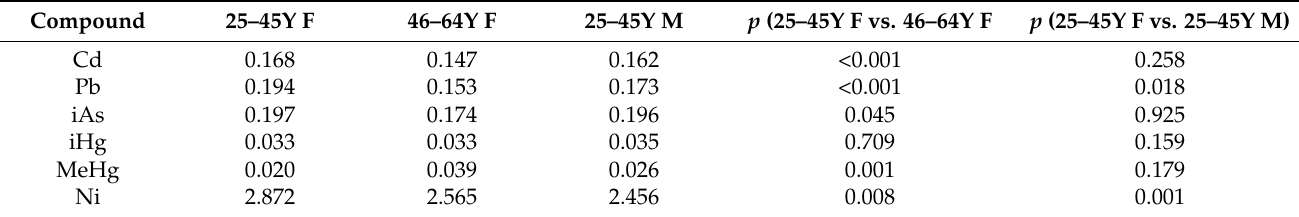
Table 5. Statistical comparison of mean exposure (in µ g/kg bw/d) in three population groups: women (F) and men (M) of 25 to 45 years, and women of 46 to 64 years. The mean exposure was assessed with FinDiet 2012 consumption data. An independent samples t -test was used, and equal variances were not assumed.